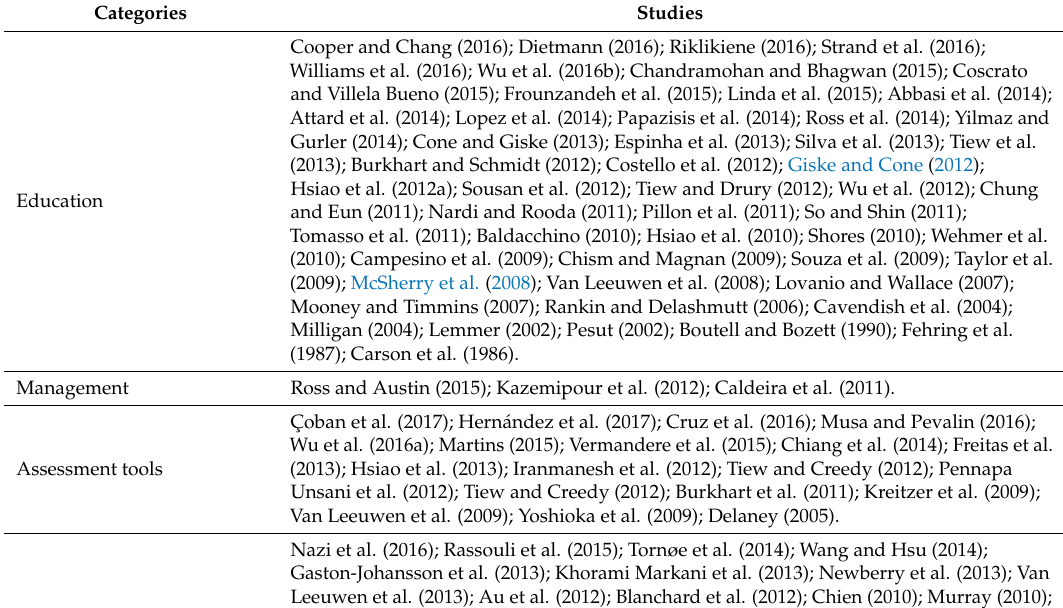
Table 2. Categories of the results in this